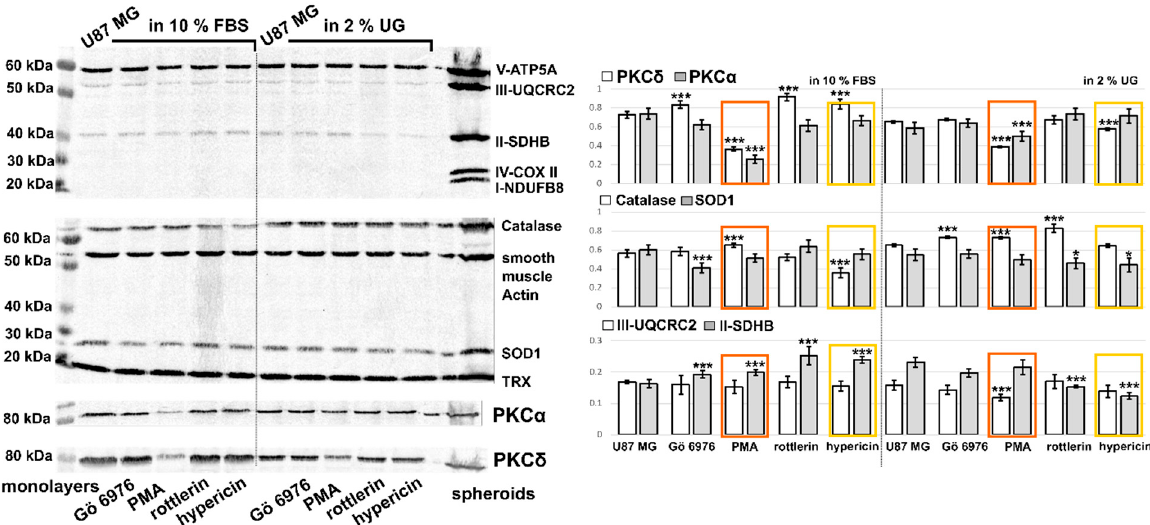
Figure 5. Western blot analysis of OXPHOS (V-ATP5A, III-UQCRC2, II-SDHB, IV-COX II, I-NDUFB8), oxidative stress defense (catalase, smooth muscle actin, SOD1, TRX), PKC α , and PKC δ levels in U87 MG monolayers grown in 10% FBS and 2% UG. The cells were exposed to 0.5 µM Gö 6976, 0.5 µM PMA (orange columns in histograms), 10 µM rottlerin, and 0.5 µM hypericin (yellow columns in histograms). The V-ATP5A complex can be considered here as a loading control. Only proteins with significant changes are plotted in histograms. Optical densities normalized with V-ATP5A are plotted in histograms. * p < 0.05 and *** p < 0.001.